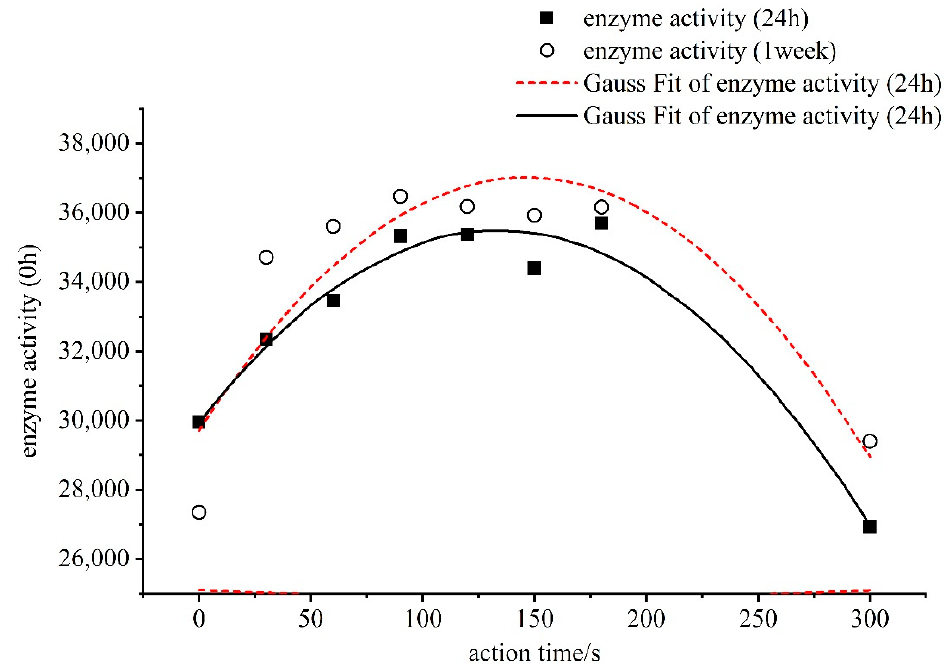
Figure 6. The relationship between α -amylase enzyme activity and duration of action. Table 2. The proportion of α -amylase enzyme activity increased by plasma.